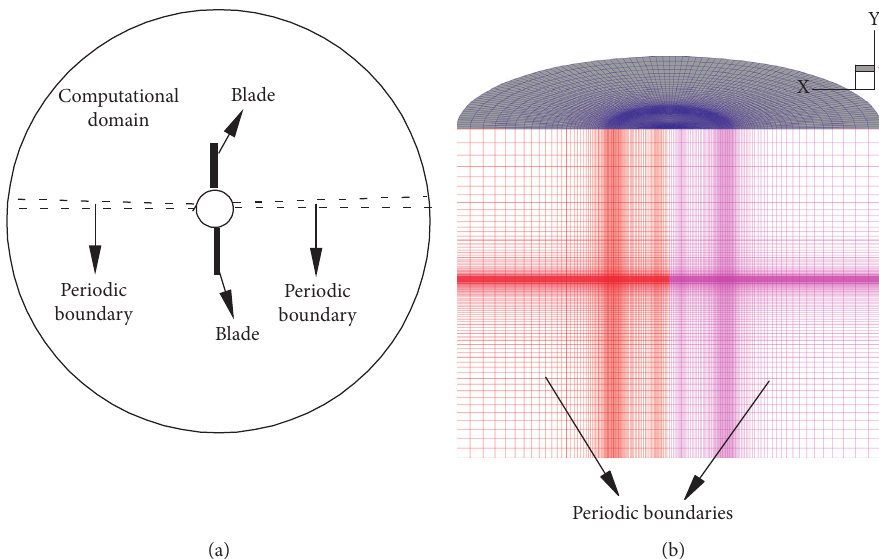
10.50-0.5-1-1.5